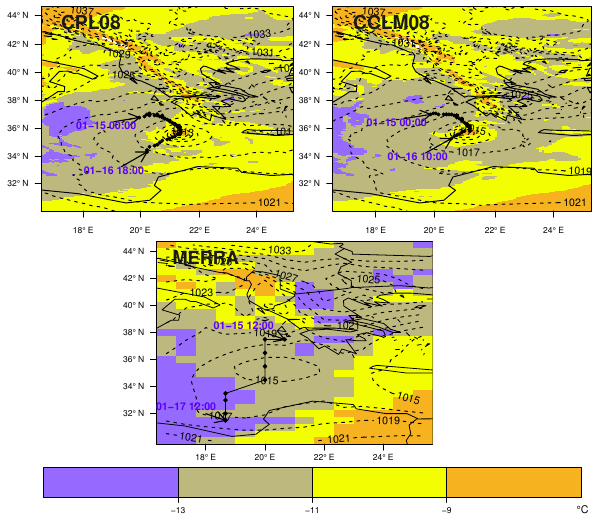
Figure 10. ME06; mean sea level pressure (hPa; dotted contours lines at 2hPa intervals) and temperature ( ◦ C: colored contours at 2 ◦ C intervals) at 700hPa in the coupled and atmosphere-only (0 . 08 ◦ ) simulations and the MERRA reanalysis data on 16 January 1995 at 12:00UTC. Black dots represent track of the